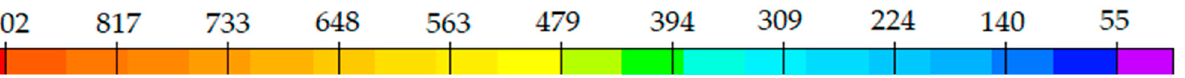
Figure 13. Temperature scale for standard fire mode.